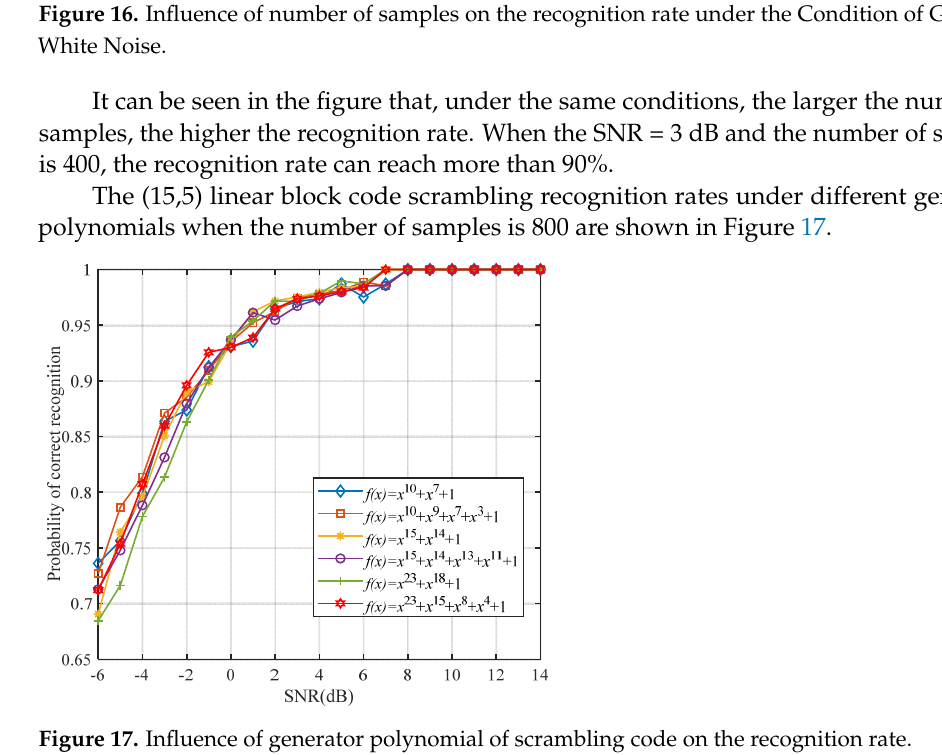
Figure 17. Influence of generator polynomial of scrambling code on the recognition rate.